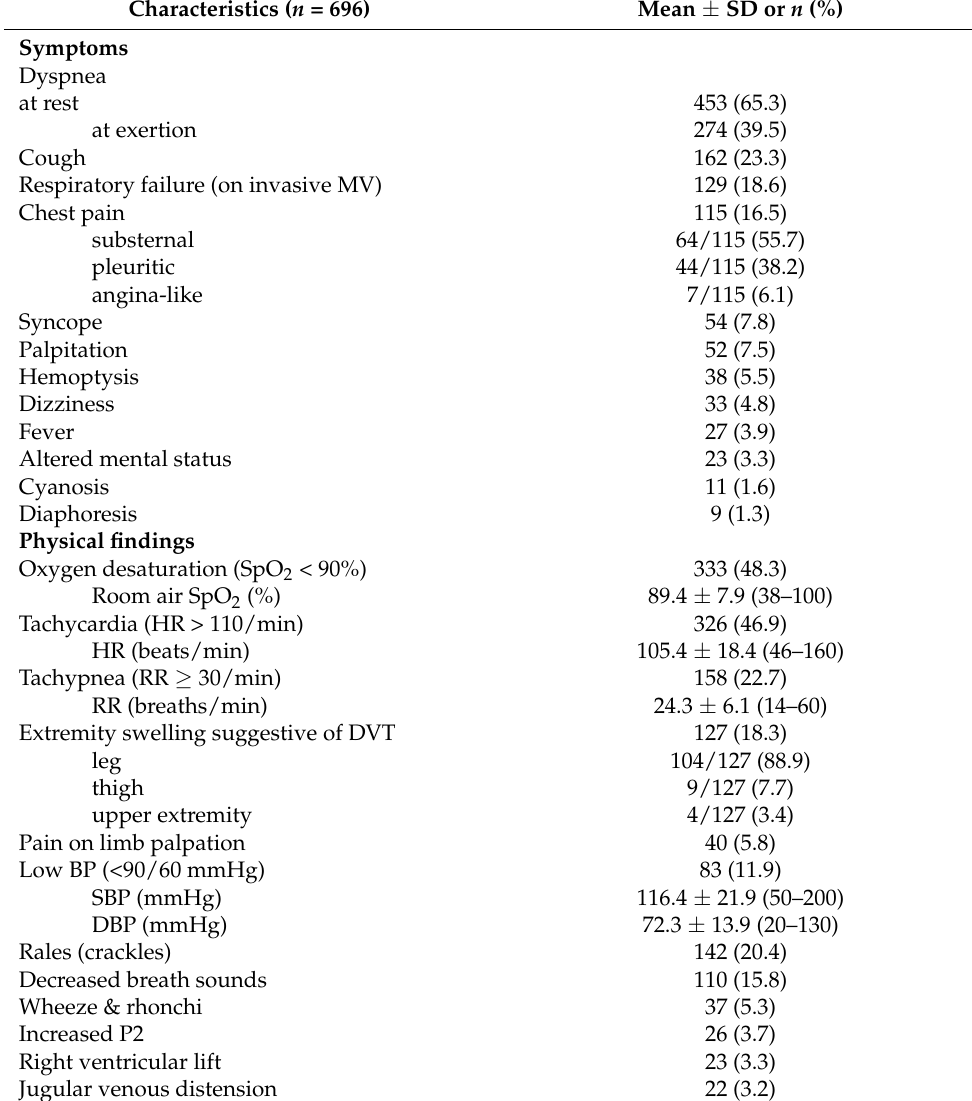
Table 2. Symptoms and Physical